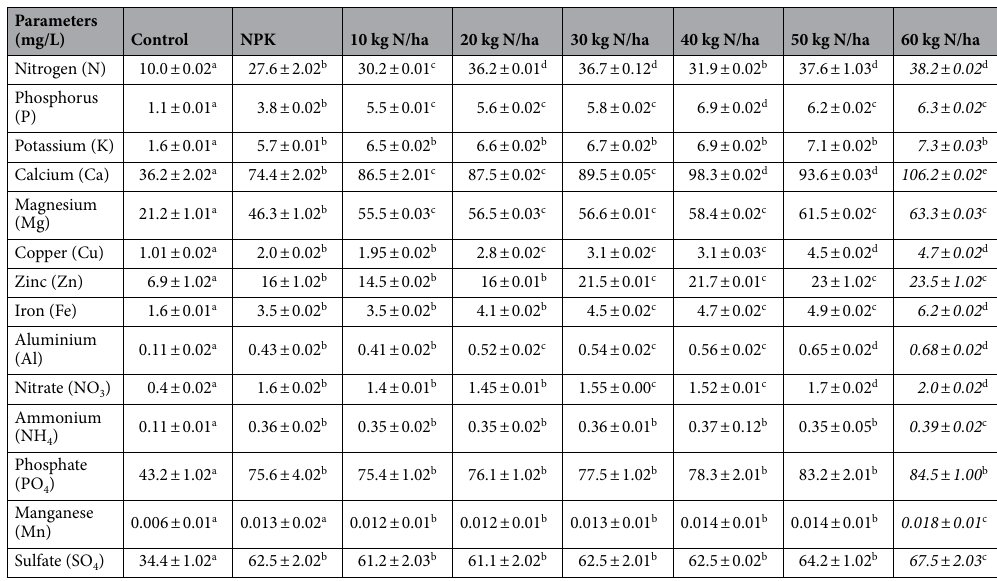
Table 8. Soil fertility improvement by Carica papaya fruit peel organic fertilizer. Values shown in table are means of triplicate analyses; superscripts with same letters are statistically the same by the Tukey’s test at 5%; Values in italics indicates highest concentrations of each parameter